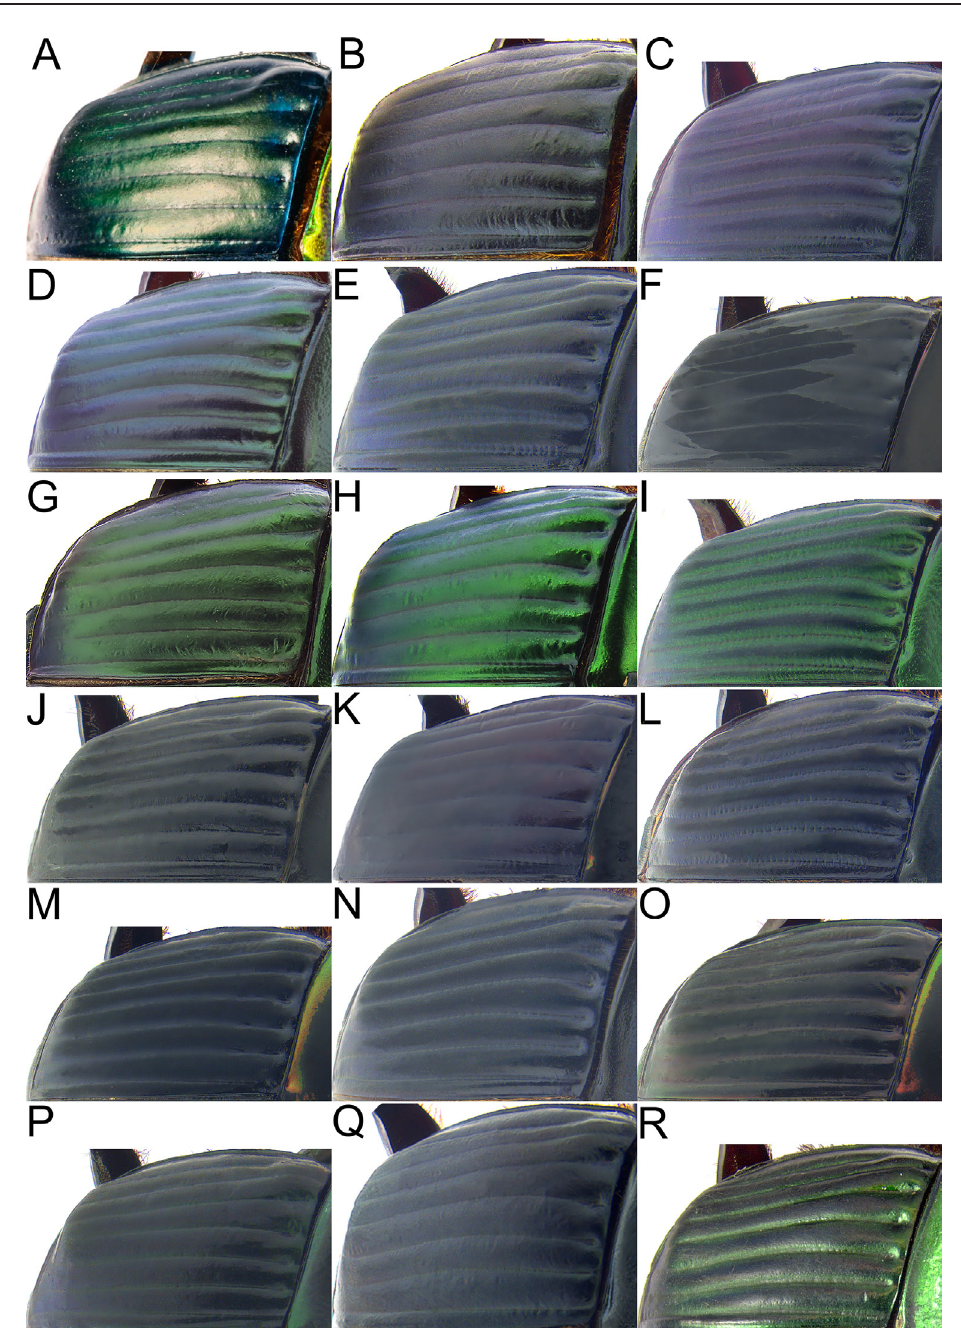
Fig. 19. Elytral integument of species within the Phanaeus endymion species group. A .